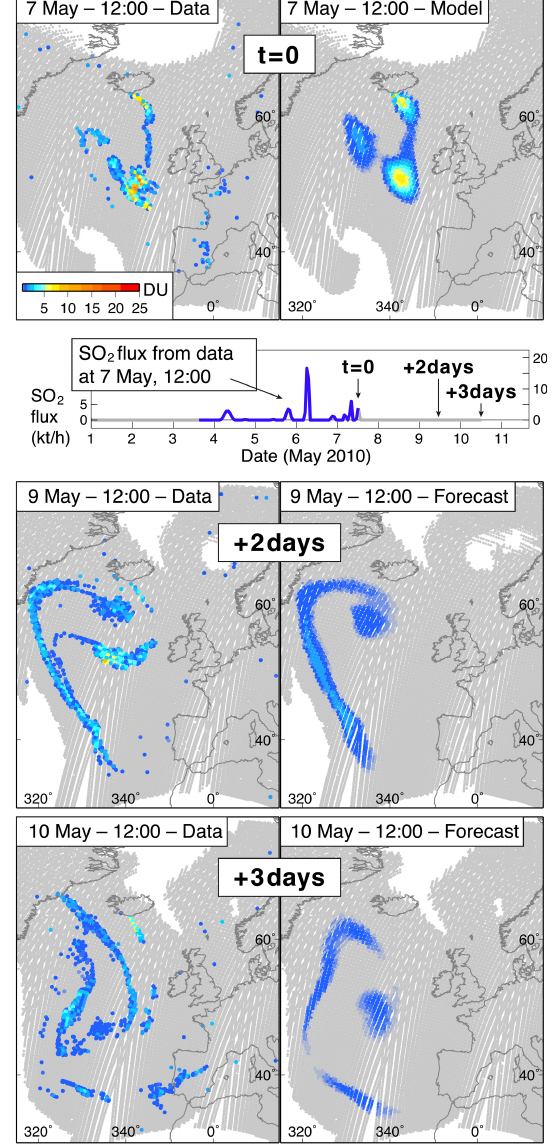
Fig. 7. Forecast at (middle) + 2 days and (bottom) + 3 days of the SO 2 plume using the source reconstructed from (top) the IASI im- age acquired on 7 May 2010 on a 12h time window centred at 12:00UTC (source c in Fig.